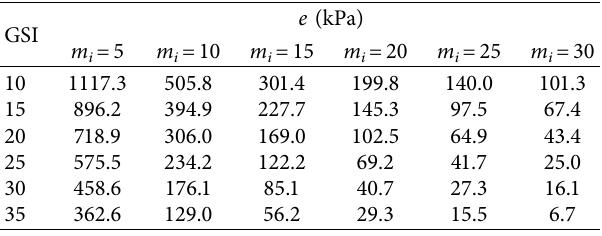
Table 7: Upper bound solution of the surrounding rock pressure q at different σ and D . ci